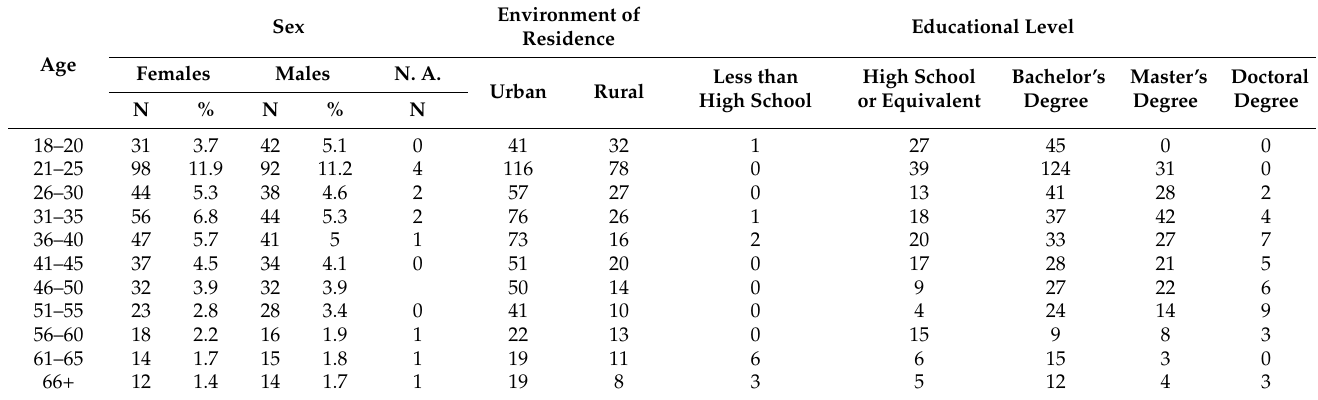
Table 2. Socio-demographic data of the participants.